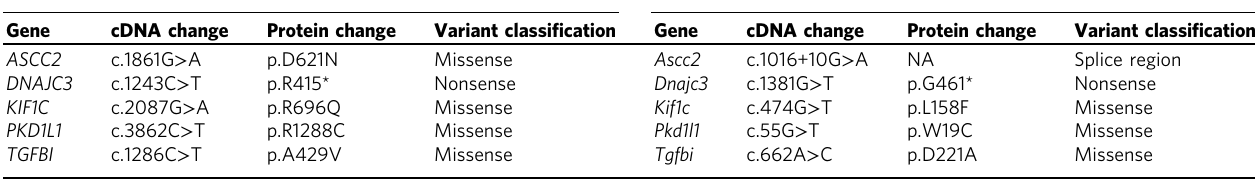
Table 1 Recurrently mutated genes in mouse and human ACP Human